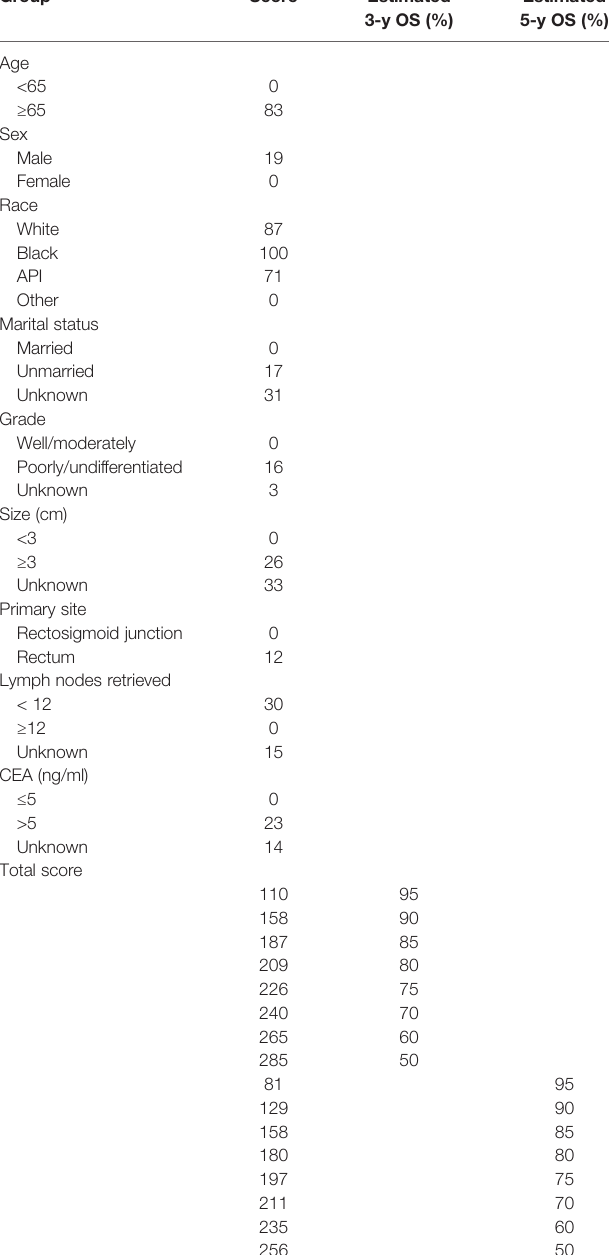
TABLE 3 | Point assignment of each component and prognostic score for T3N0 rectal cancer.